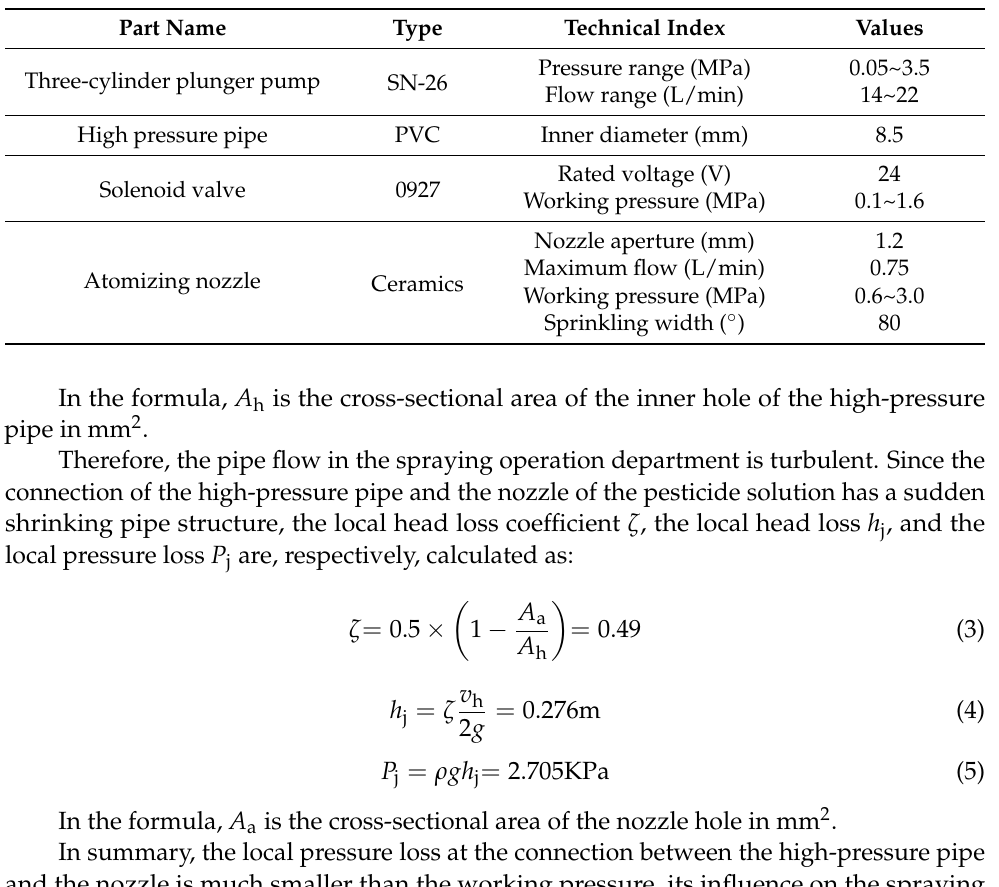
Table 3. Main technical parameters of the spraying operation